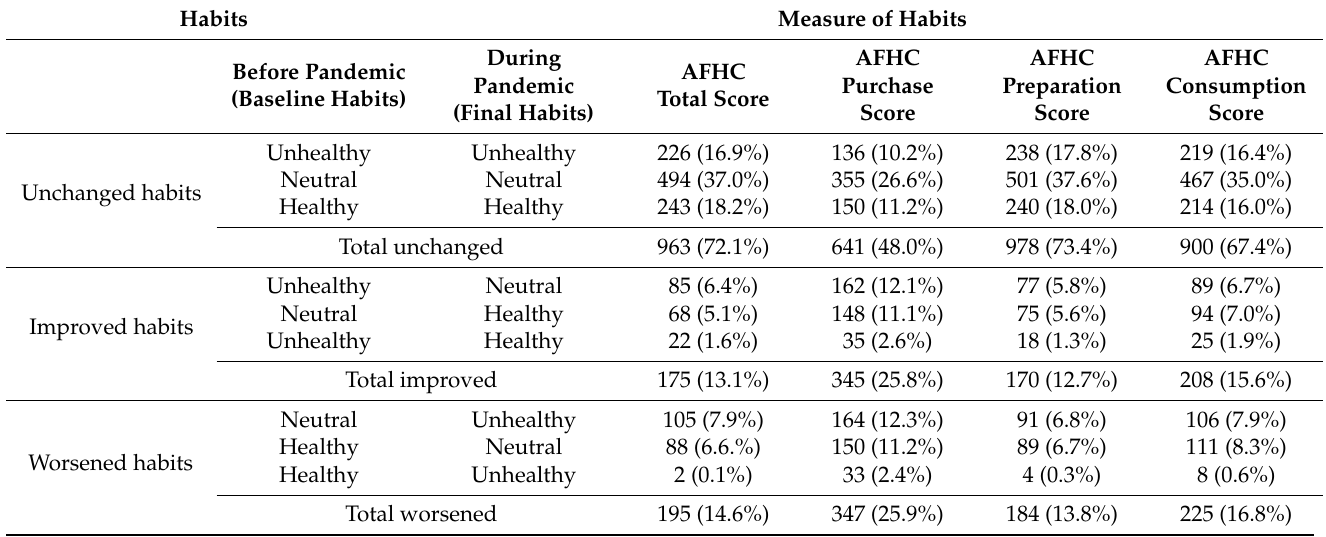
Table 9. The changes in Adolescents’ Food Habits Checklist (AFHC) scores during the COVID-19 pandemic, in categories of healthy, neutral, and unhealthy habits, for the total population of adolescents from the Diet and Activity of Youth during COVID-19 (DAY-19) Study ( n =